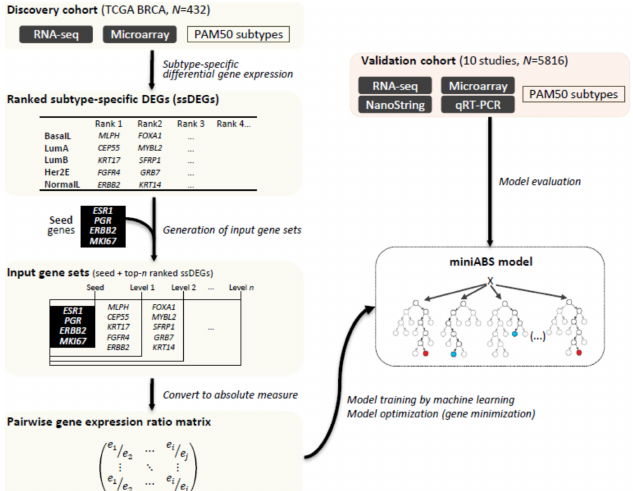
Figure 1. Overview of MiniABS. To identify the features used to classify the molecular subtypes of the model, subtype-specific DEGs (ssDEGs) were identified using the Wilcoxon rank-sum test. We set up an input gene set for gene selection with the ability to classify subtypes with a minimal gene set. Four well-known machine learning models with pairwise gene expression ratios (PGERs) were used to learn and optimize the models. The model with the best accuracy was selected. The performance thereof was evaluated by applying the model to the test set from the discovery set. Finally, we evaluated whether the final selected model (MiniABS) works well with an independent validation dataset and has